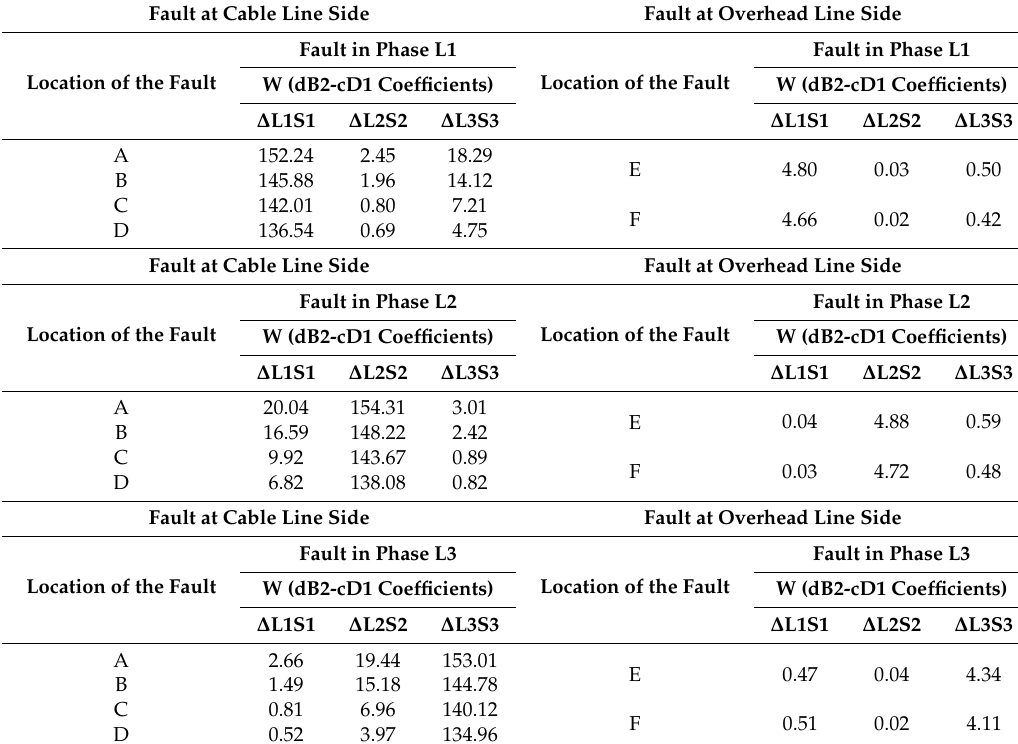
Figure 20. Wavelet analysis of the angular differences with a ground fault at the cable line side in phase L1. Fault point C. Table 6. Ground fault at overhead and cable line sides. Wavelet analysis: experimental results. Overhead line side solidly grounded and cable line side isolated.